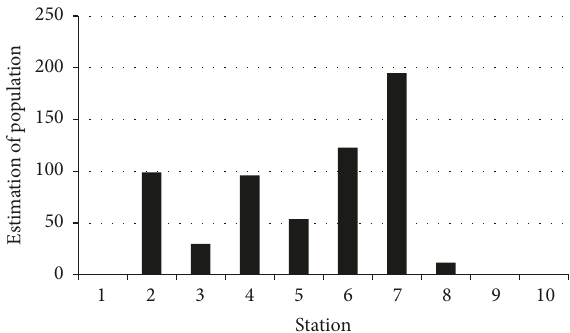
Figure 3: Holothuria leucospilota found from an intertidal area of Satang Besar Island.